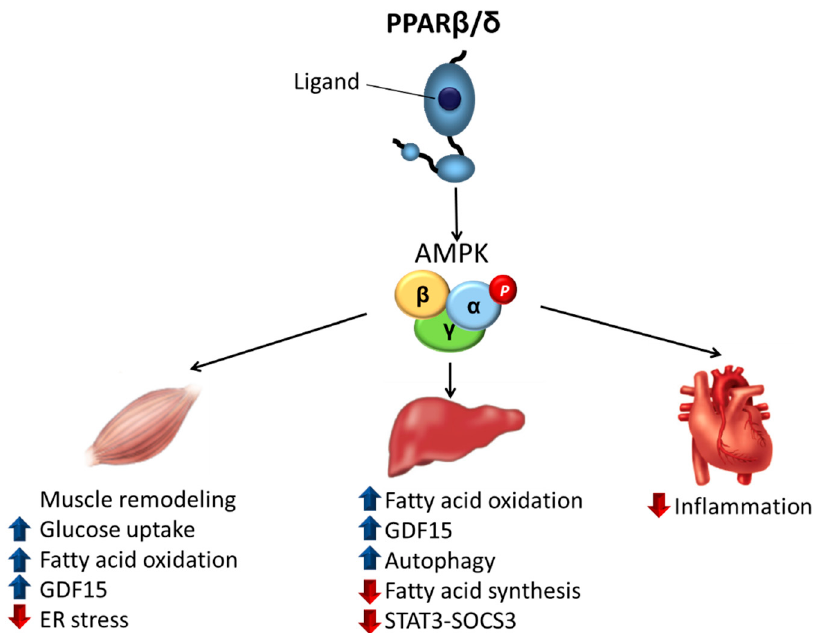
Figure 2. Antidiabetic effects of the PPAR β / δ -AMPK pathway in different organs. AMPK, AMP- activated protein kinase; ER, endoplasmic reticulum; GDF15, growth differentiation factor 15; PPAR β / δ : peroxisome proliferator-activated receptor β / δ ; SOCS3: suppressor of cytokine signaling 3; STAT3: signal transducer and activator of transcription 3.